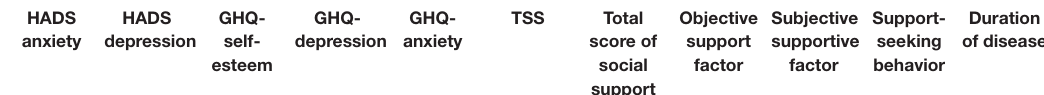
TABLE 2 | Correlation coefficient and P- value between two continuous